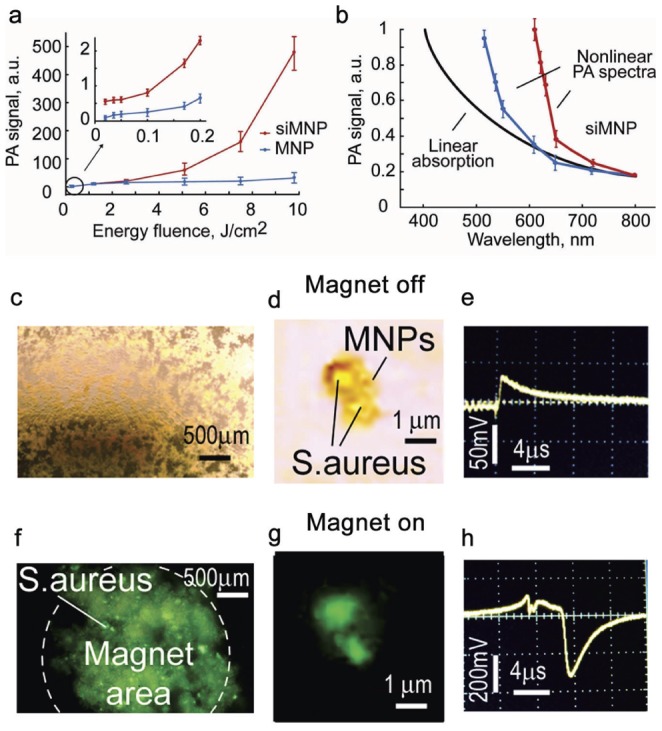
Giant nonlinear signal amplification in single siMNPs and magnet-induced siMNP clusters.(a) Nonlinear PA signal amplification from siMNPs (red curve) compared to MNPs without a silica layer (blue curve) at 639 nm. (b) Nonlinear PA spectra of siMNPs (blue and red curves) at 0.3 and 5 J/cm2 energy fluences. Black curve indicates the linear absorption spectrum. PA spectra were normalized on absorption spectra at 800 nm. The error bars represent the standard deviations in five measurements. (c–h) Optical (c, d) and fluorescent (f, d) images of many (c, f) and two (d, g) S. aureus labeled by 30-nm siMNPs with FITC, and PT signals from two labeled bacteria before (e) and after (h) magnet exposure for 3 minutes. Laser parameters: wavelength, 640 nm; energy fluence, 200 mJ/cm2; pulse rate, 10 Hz.